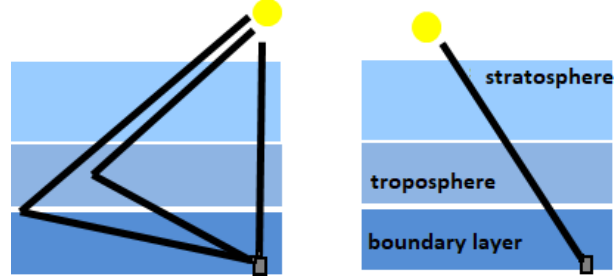
Figure 1. Sketches illustrating the MAX-DOAS and direct sun viewing